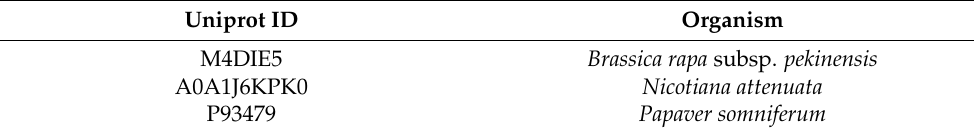
Table 1. Berberine bridge enzymes that catalyze the production of cannabinoids.